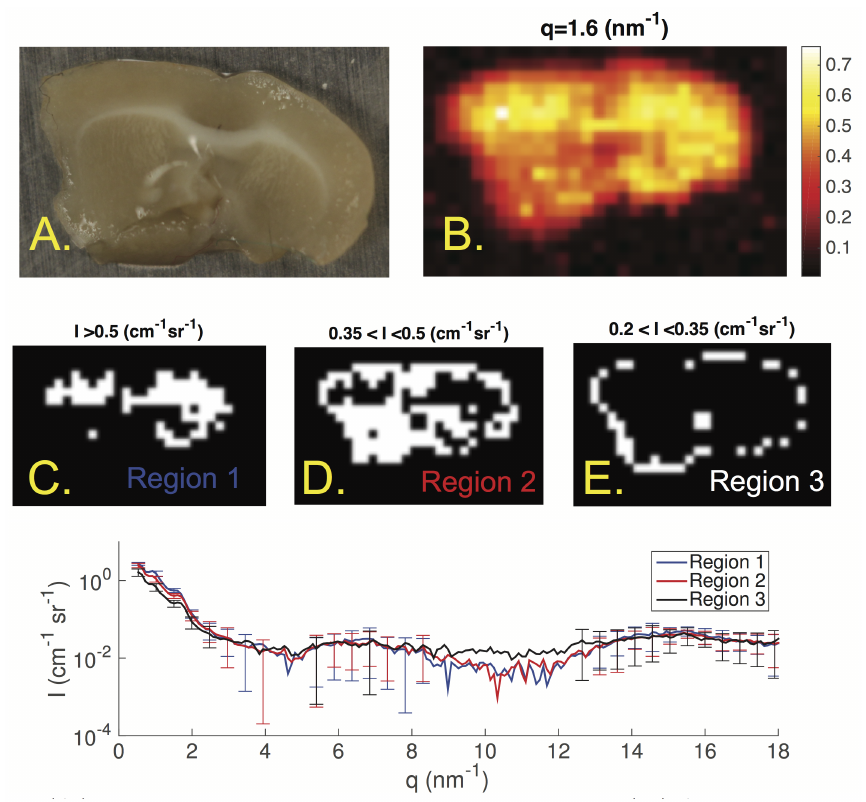
Fig 5. (A.) Photographof a coronal slice in a mouse brain. (B.) An intensity map at q = 1.60 nm − 1 . (C.) First regionwhere intensity was higher than 0.50 cm − 1 sr − 1 in B. (D.) Second regionwhere the intensity was between0.35 and 0.50 cm − 1 sr − 1 in B. (E.) Third regionwhere the intensity was between0.20 and 0.35 cm − 1 sr − 1 in B.(Bottom) Scatter profiles of the averageof pixels in the three regions depicted in C,D and E. Error bars are ± σ of the pixels in each region. They are plotted every 10 points for clarity.